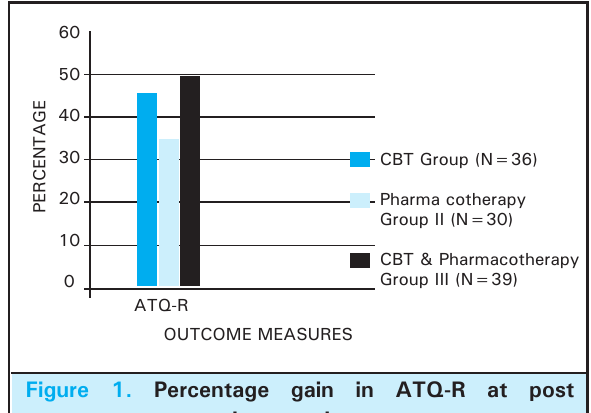
Figure 1. Percentage gain in ATQ-R at post assessment among intervention